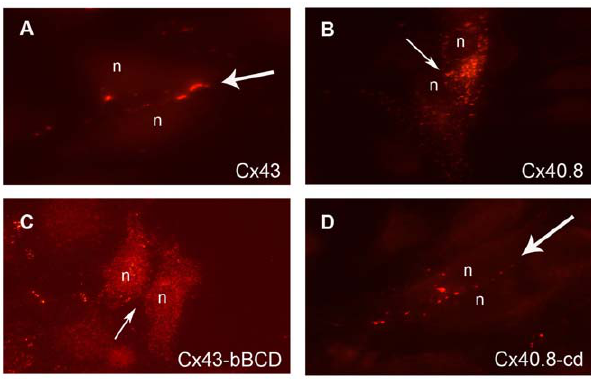
Figure 6. Untagged Cx43 and Cx40.8 constructs behave similarly as GFP tagged constructs in transiently transfected HeLa cells. (A) Cx43 localizes to the plasma membrane. (B) Cx40.8 is retained intracellularly. (C) Cx43-bBCD is retained intracellularly. (D) Cx40.8-cd localizes to the plasma membrane. The Cx43 antibody [12] was used to detect untagged Cx43 and untagged Cx43-bBCD. The Cx40.8 antibody was used to detect untagged Cx40.8 and untagged Cx40.8-cd. Flared arrows identify gap junction plaques located at the plasma membrane; Plain arrows identify the plasma membrane in the absence of gap junction plaques; n, nucleus.